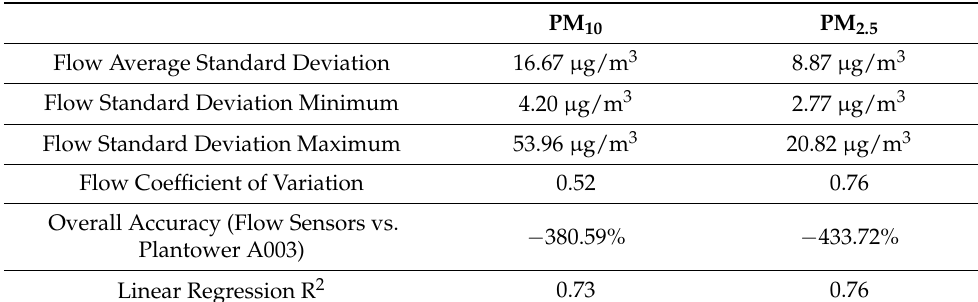
Table 2. Preliminary